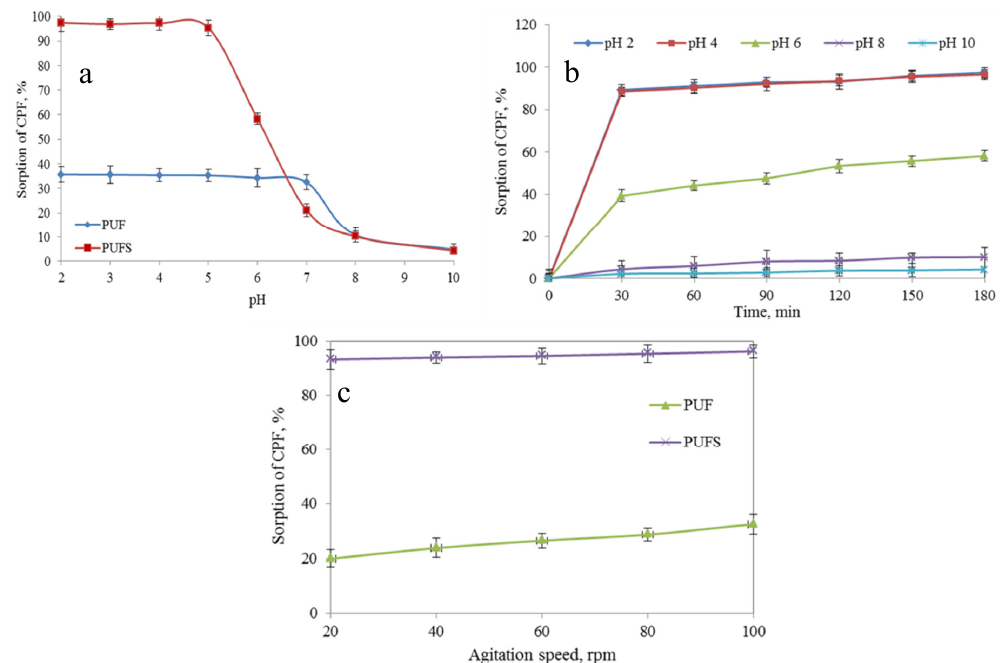
Figure 6. ( a ) Effect of aqueous pH value; ( b ) effect of initial pH value and shaking time; ( c ) effect of shaking time on CPF sorption percentage onto white PUF and PUFS. Experimental conditions: 25 mL volume of CPF; 10.0±0.02μg/L solution (aqueous phase); adsorbent dosage 0.3 mg/L, agitation speed 100 rpm, temperature 25 °C.